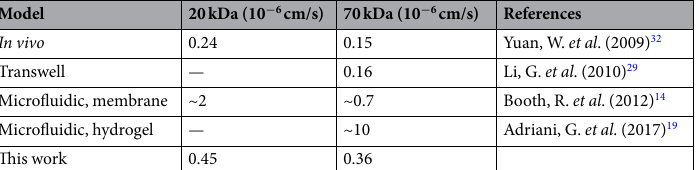
Table 1. Permeability coefficients in various in vitro BBB models measured by 20 kDa and 70 kDa FITC-